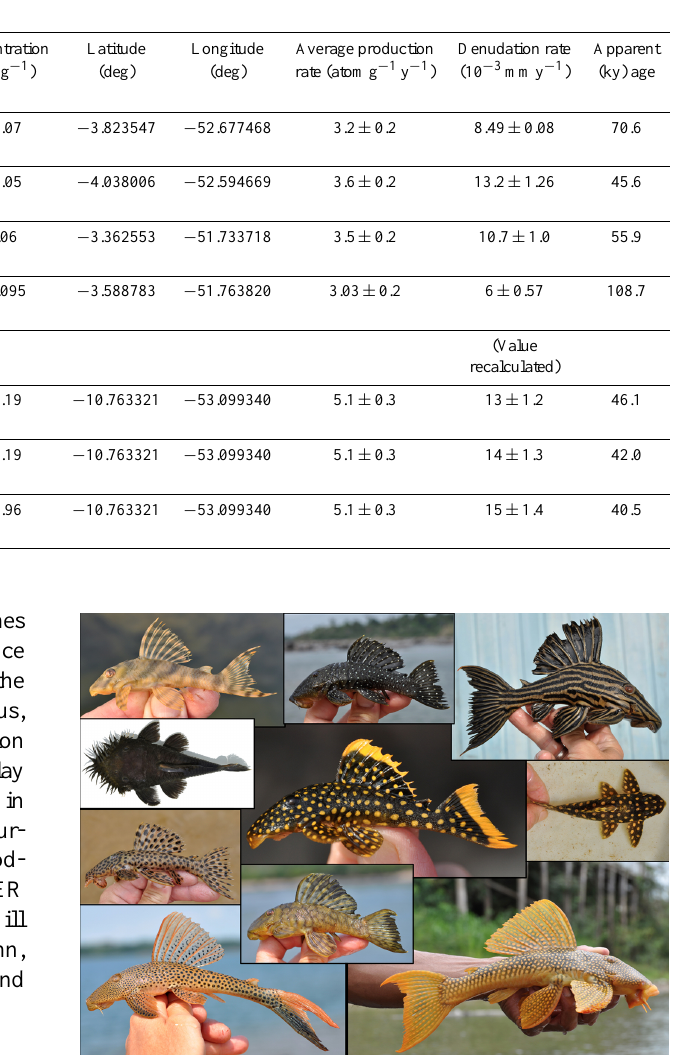
Table 2. Fluvial sand 10 Be concentration and calculated catchment-wide average denudation rates for catchments above sampling points in the Xingu River and the Iriri and Bacajaí tributaries. Production rates obtained by averaging pixel-by-pixel the production rates calculated according to the Lal (1991) and Stone (2000) scaling scheme, using the global production rate in Heyman (2014). Full data set given only for samples measured in this study. For comparison of final results, we also present the final 10 Be data by Wittmann et al. (2011). AMS 10 Be / 9 Be ratio for the blank: 2 . 019 ± 0 . 425 × 10 − 15 . Standard used for normalization 07KNSTD3110, with a 10 Be / 9 Be ratio of 2 . 85 × 10 − 12 . Samples measured after adding a Be carrier solution of density 1.013gmL − 1 , at a concentration of 282ppmBe. Carrier added to blank: 0.825g.